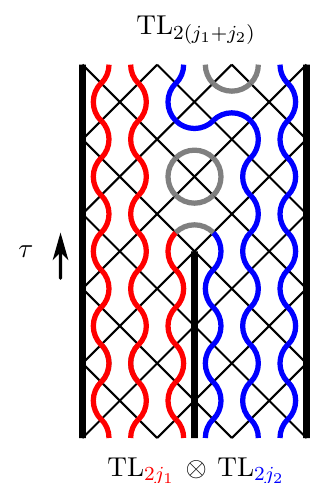
Figure 1 . Physical interpretation of the fusion of two standard TL modules W j (in the picture, N 1 = 2 j 1 and N 2 = 2 j 2 so that both standard modules are one-dimensional).